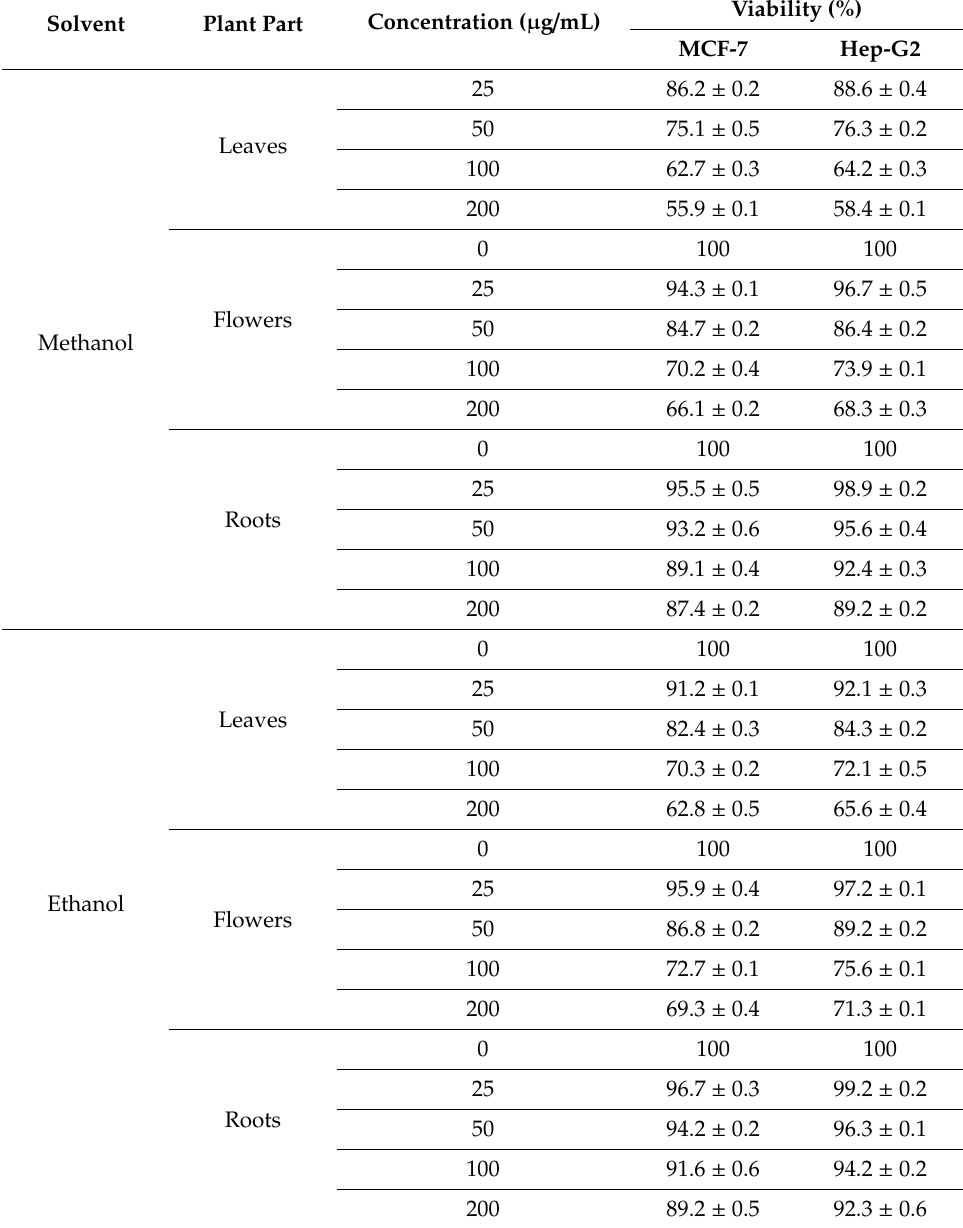
Table 3. Cytotoxic activity of Nepeta juncea extracts toward human cancer cell